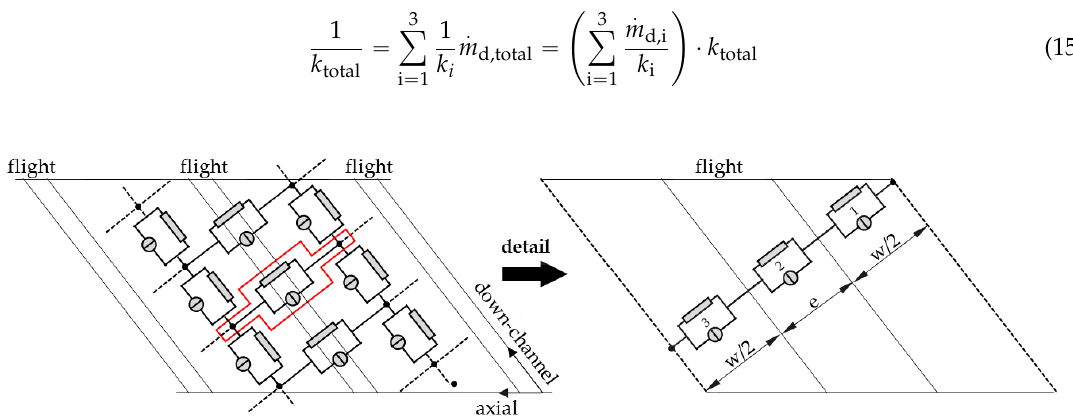
Figure 8. Network of a melt-conveying section. Cross-channel connections between nodal points were initialized with three elements connected in series and then replaced with one equivalent element.